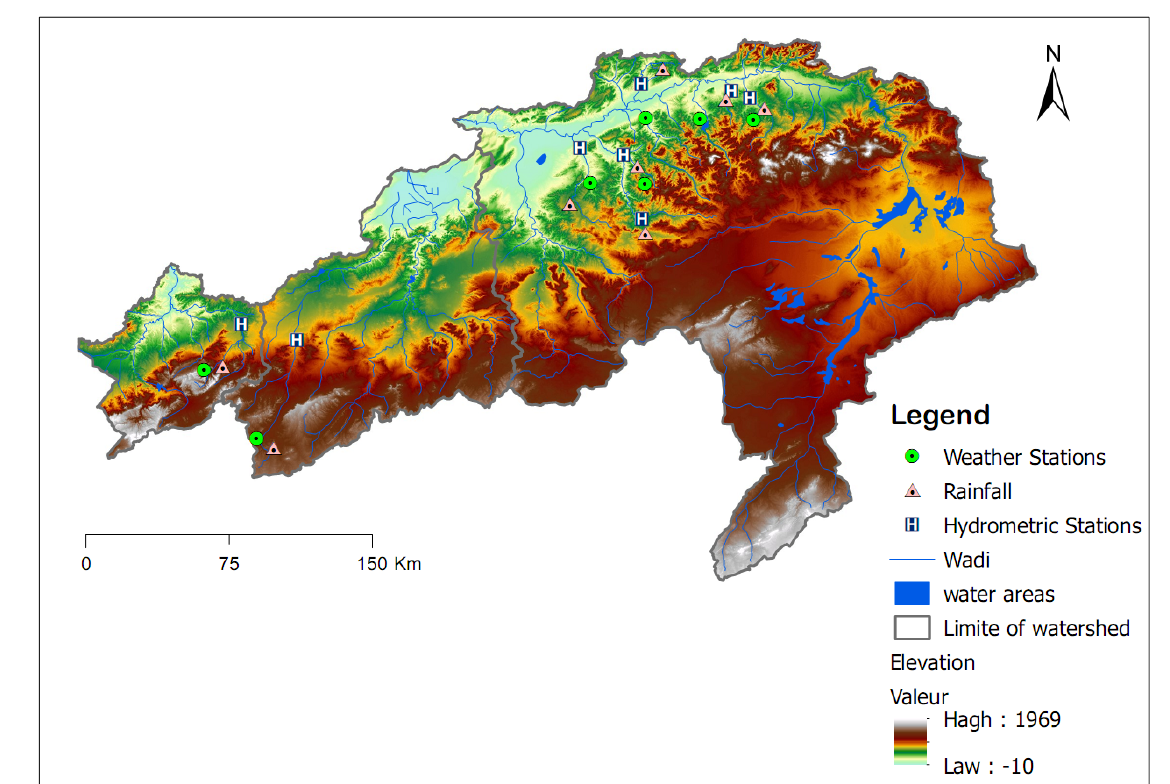
Figure 1. Cheliff-Mactaa-Tafna basin climate and streamflow stations.